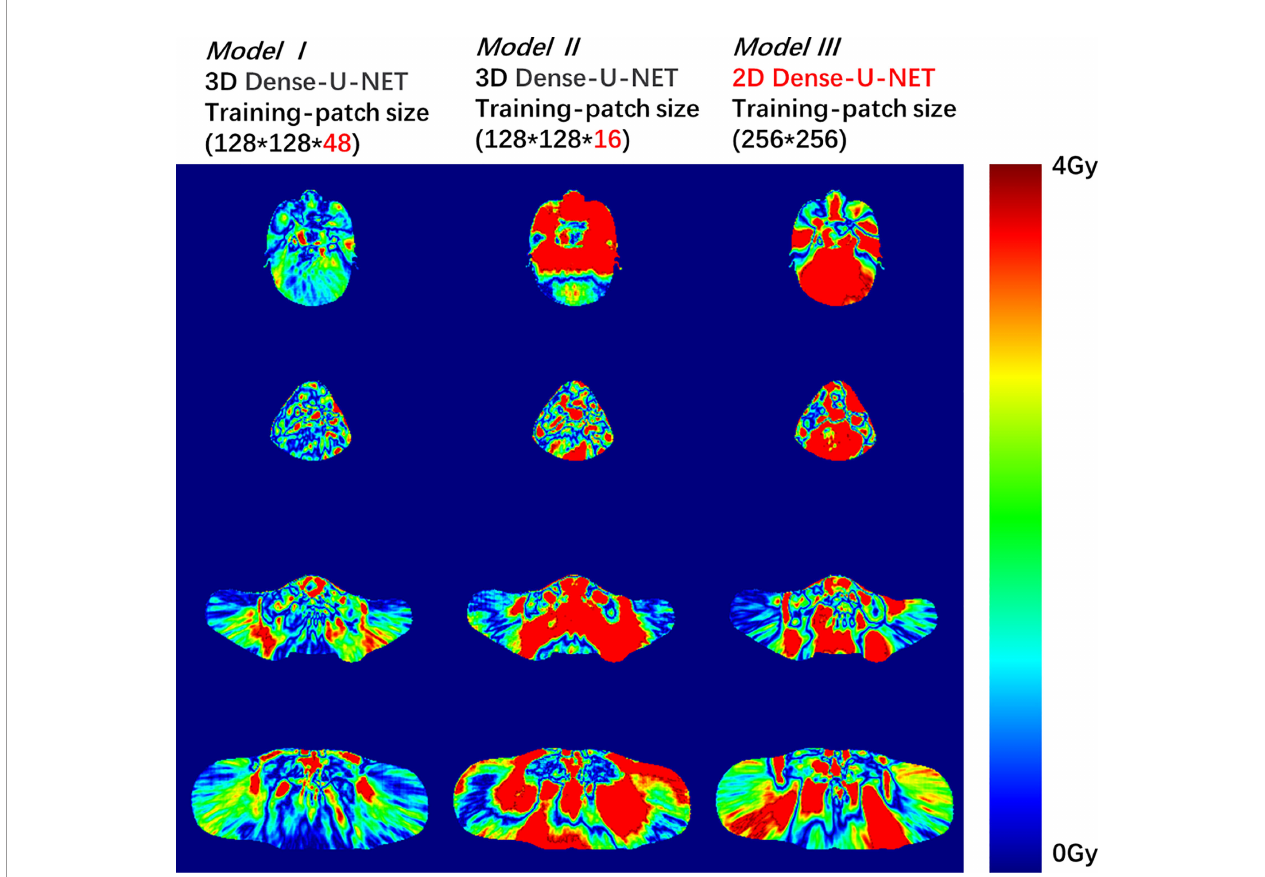
FIGURE 2 | Dose difference between the predicted dose distribution and the ground truth for Model I, II, or III. The deep red color shows the dose difference beyond 4